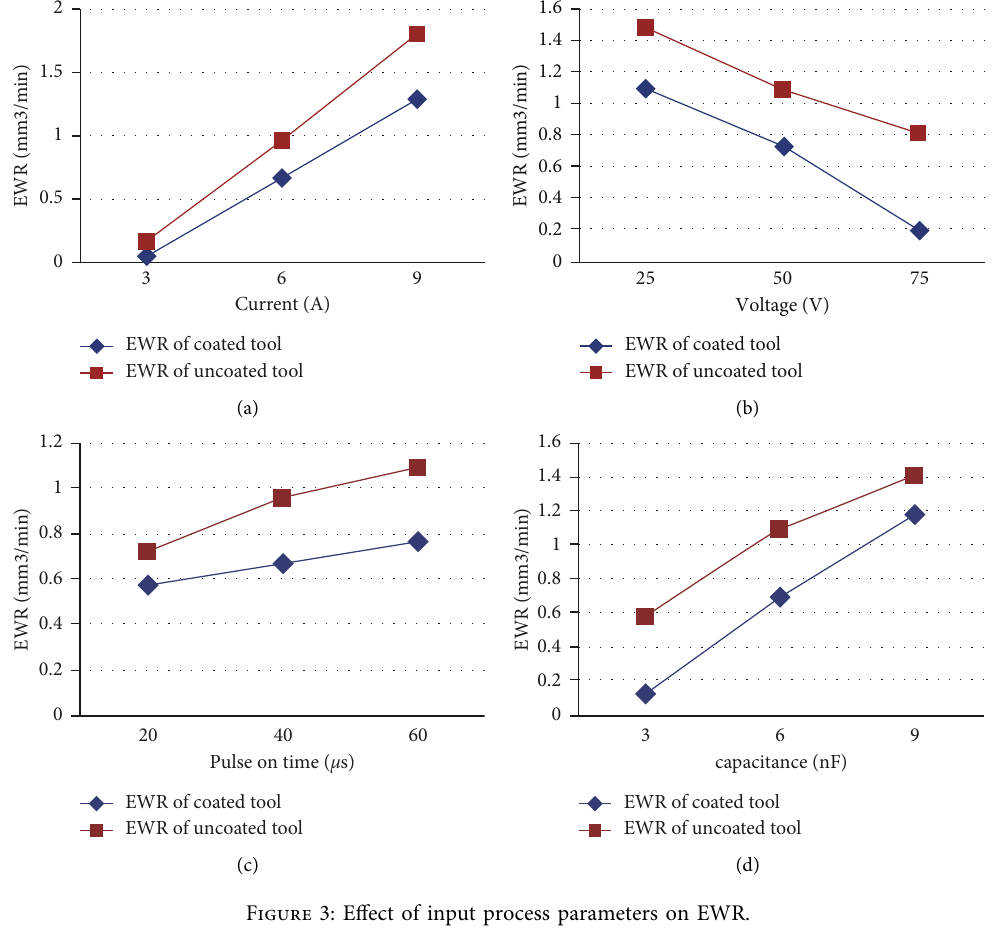
Figure 3: Effect of input process parameters on